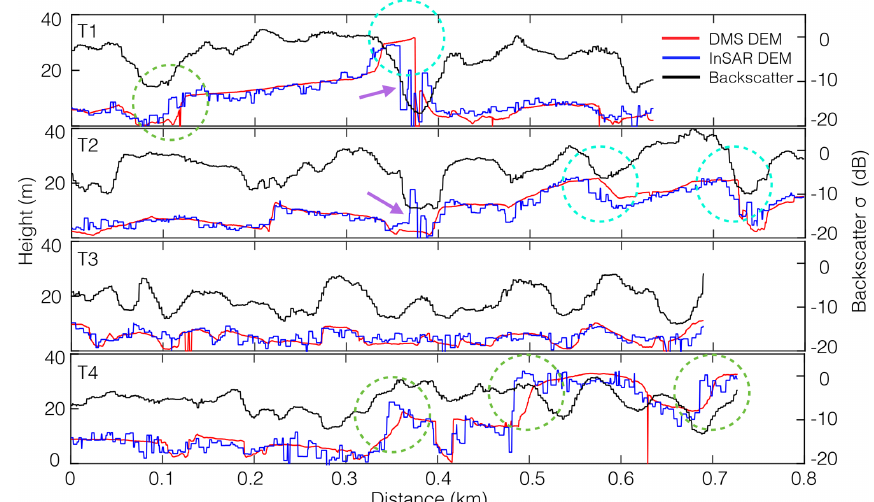
Figure 5. Comparison of interferometric height (InSAR DEM) (blue), backscatter (black), and OIB DEM (DMS DEM) (red) along transects. Dashed circles indicate locations of significant discrepancy between DEMs, either where DMS DEM > InSAR DEM (turquoise) or DMS DEM < InSAR DEM (green). Purple arrows indicate sections of significant ( > 10m) variability in the InSAR DEM not present in the DMS DEM.